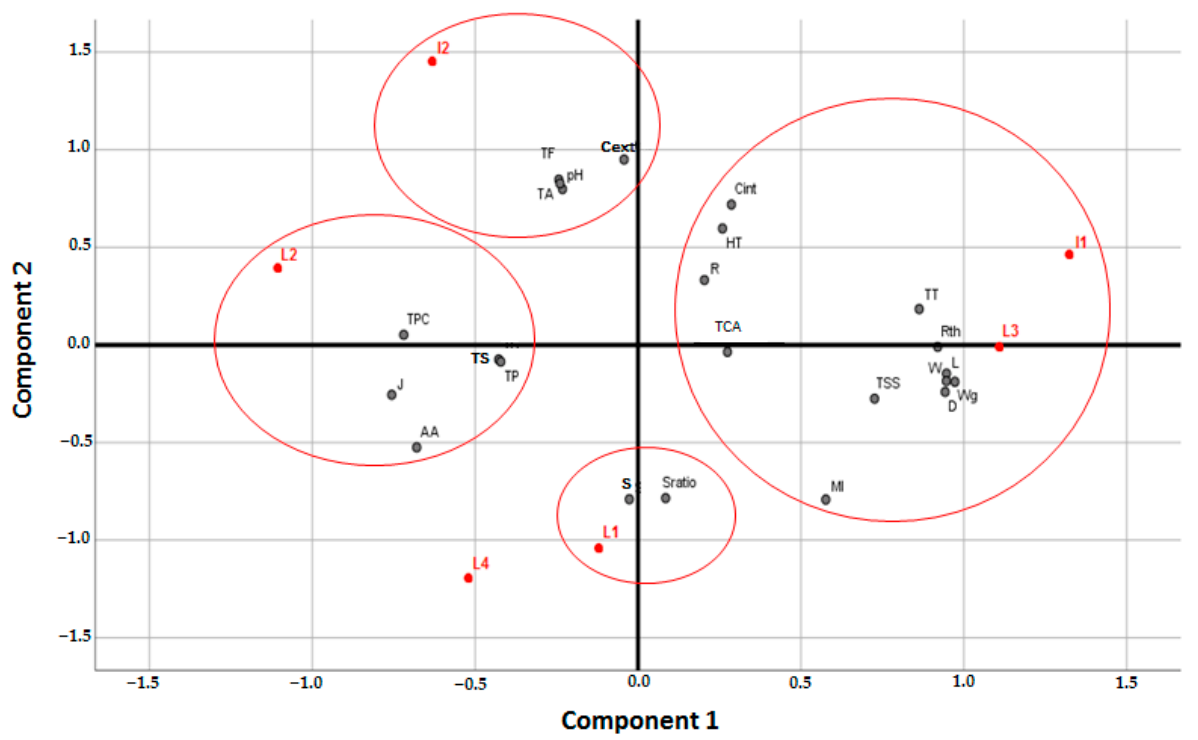
Figure 2. Principal component analysis (PCA) of selected varieties (L1, L2, L3, L4, I1, and I2) using fruit morphology and juice physico-chemical characters.